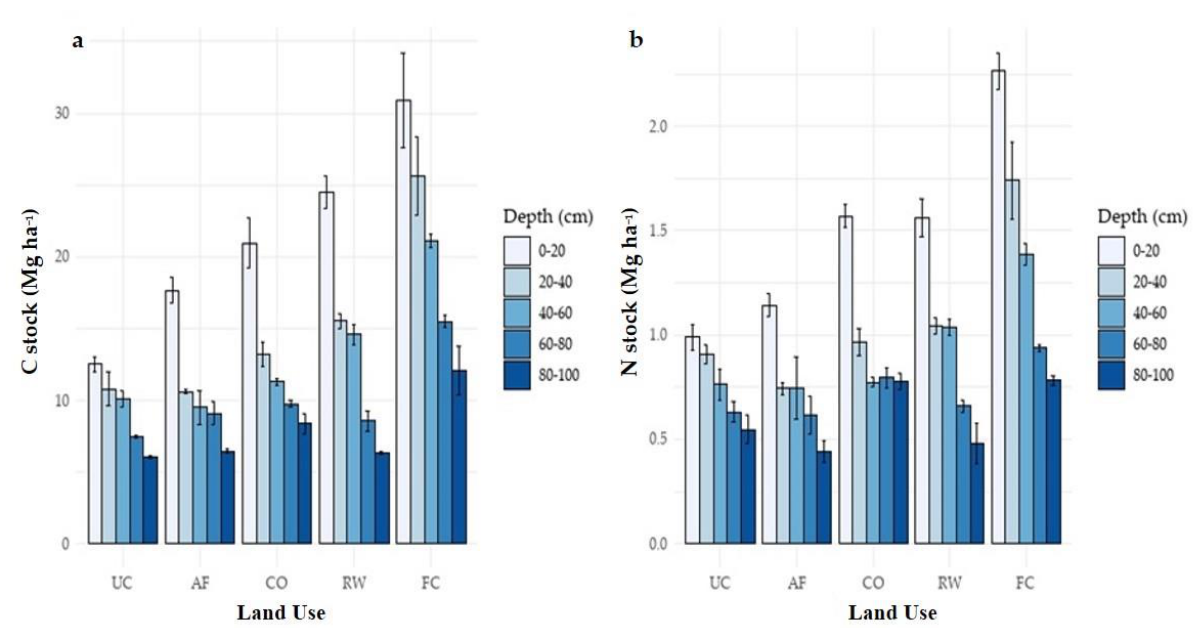
Figure 2. ( a , b ) Soil organic carbon and nitrogen stock at different soil depths in different land use systems in hot, arid environment. UC, uncultivated; AF, agroforestry; CO, citrus orchard; RW, rice–wheat system; FC, forage crop.